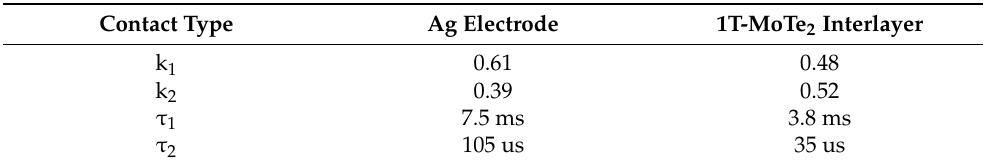
Figure 5. Normalized photoconductivity as a function of the frequency of Ag and 1T-MoTe 2 interlayer electrode contacts of 2H-MoTe 2 . Table 1. The obtained values of coefficients from the least-square fits to Equation (1) for the 2H-MoTe 2 using Ag and 1T-MoTe 2 interlayer electrode contacts.